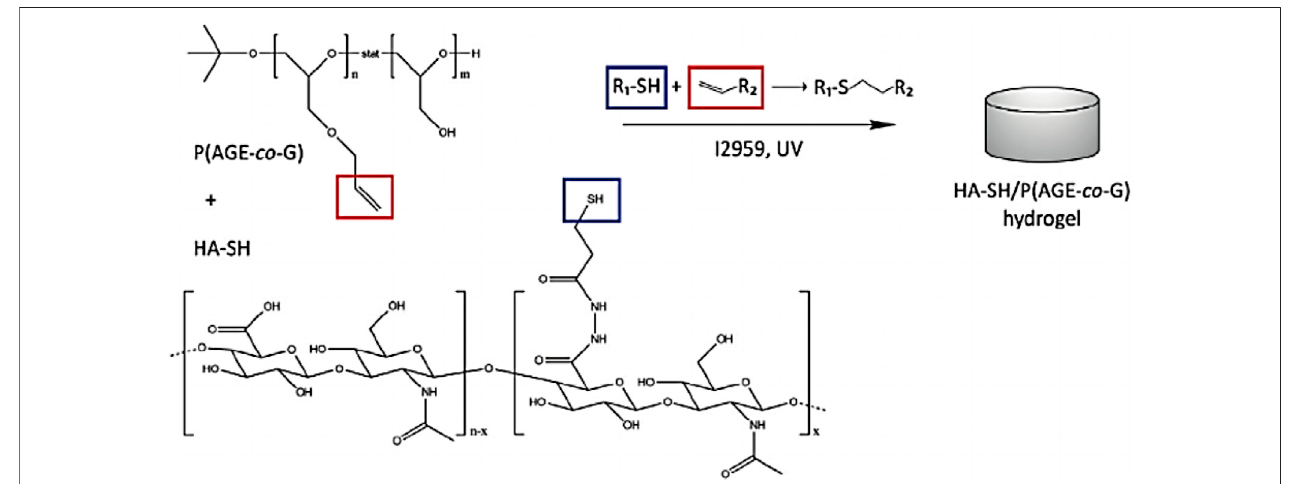
FIGURE2| Chemicalstructure andcross-linking mechanism ofhydrogels.Reproduced from Hauptsteinetal., (2020) withpermission from Copyright2020Wiley.